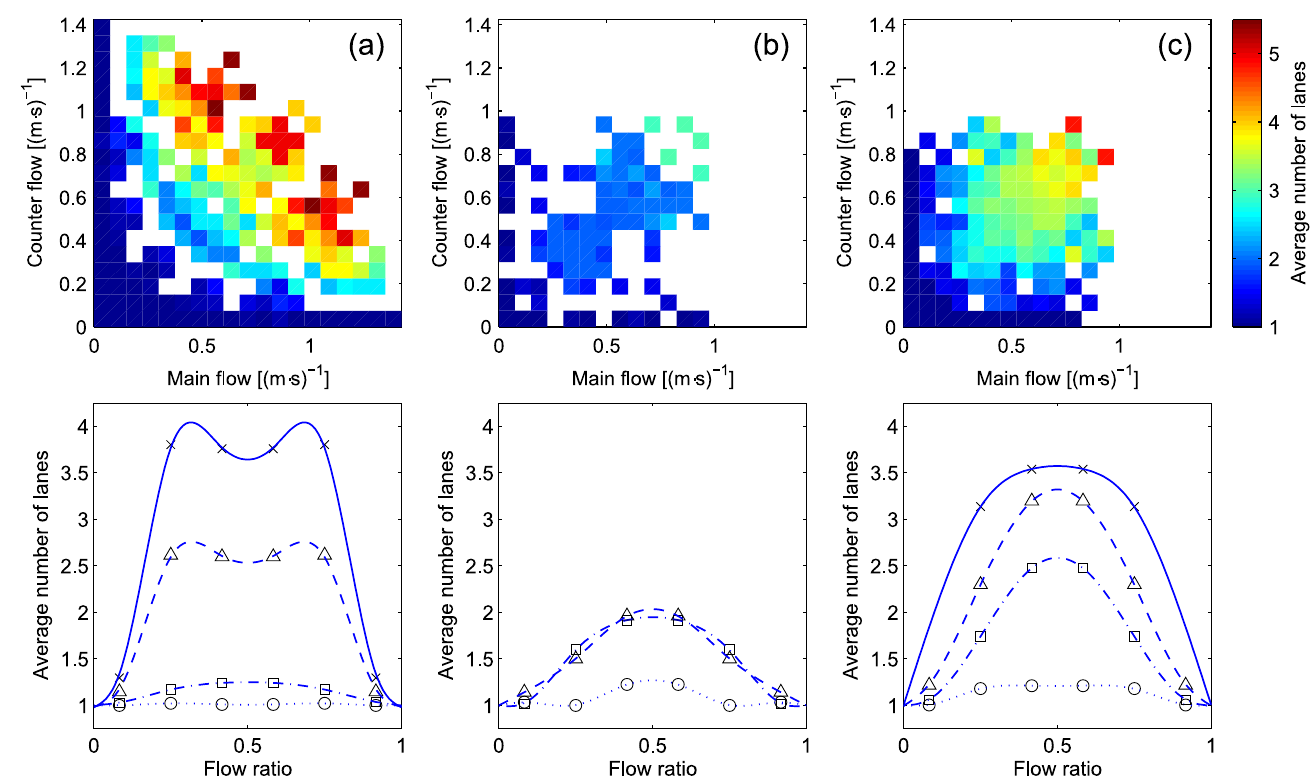
Fig 11. Average number of lanes. The same color scale is used for all scatter plots. Interpretation for the flow ratio representation is provided in Table 4.